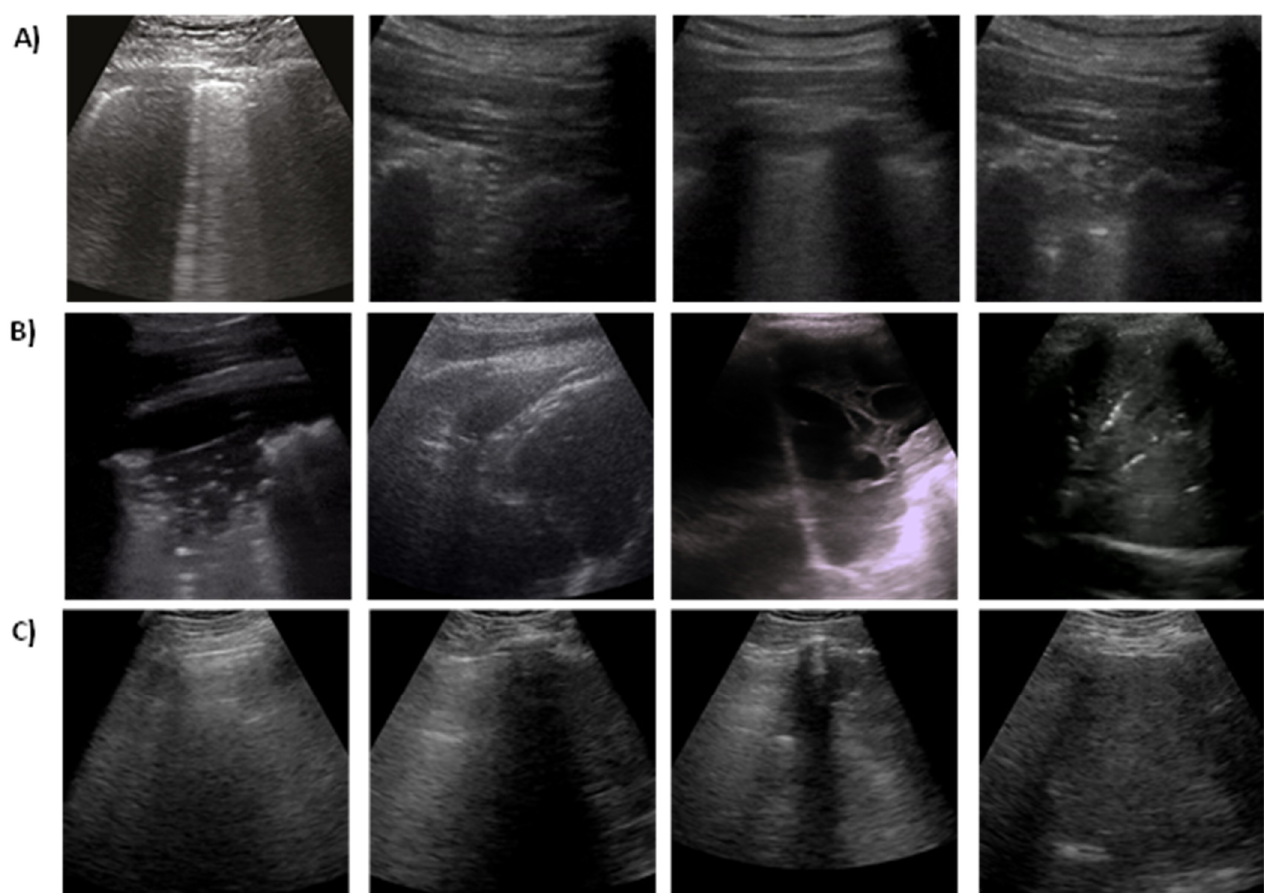
Figure 2. Examples of lung ultrasound images for different pulmonary diseases: ( A ) COVID-19, ( B ) Pneumonia, ( C ) normal case.